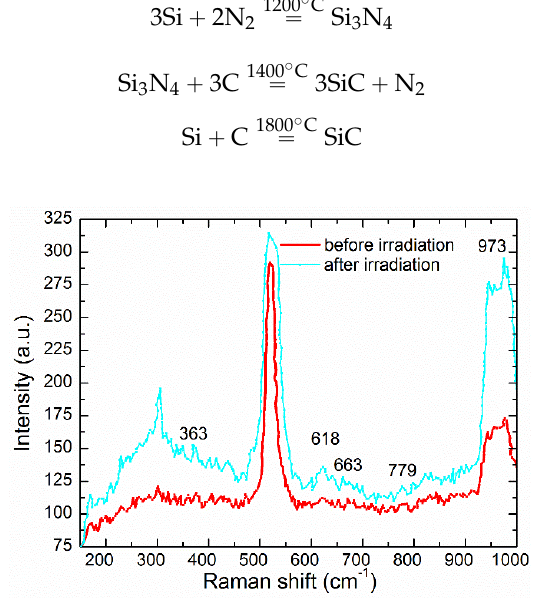
Figure 5. Raman spectra of MWCNTs. ( Red ) before laser irradiation; ( Blue ) after 12.5 s laser irradiation.